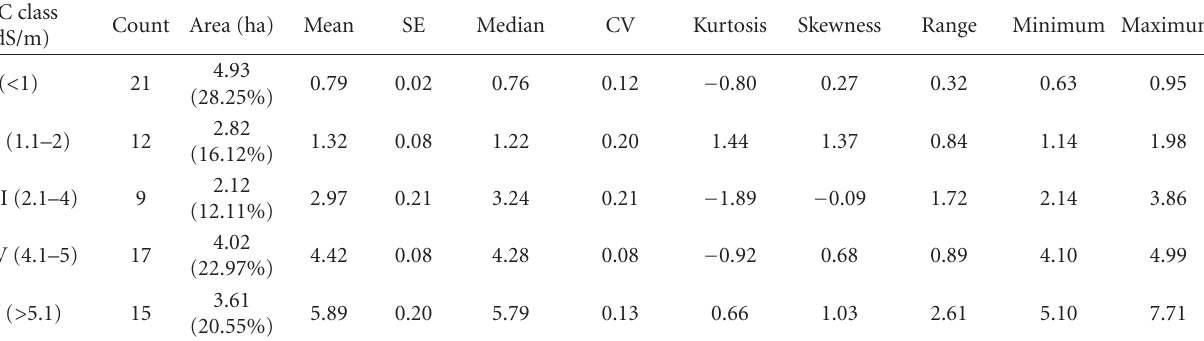
Table 6: Five classes of EC 1:1 , number of count in each class, area, mean, standard error (SE), median, coe ffi cient of variation (CV), kurtosis, skewness, range, minimum (min), and maximum (max) at 20–40 cm depth during 2010.